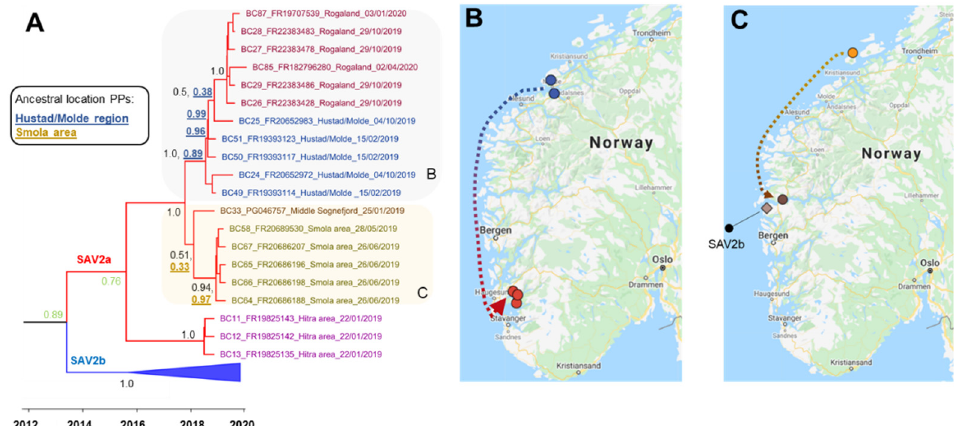
Figure 5. ( A ) Time-calibrated Bayesian phylogeny (Figure 4), focussing on the SAV2a clade, including results of the phylogeographic model. Tip names are colored according to the region of sample origin. PP values for key nodes are shown in black font. PP values for the ancestral location of samples are shown at relevant nodes, using font colors matching the given key for different aquaculture regions. ( B ) Inferred scenario of SAV2a spread from the Hustad/Molde area to Rogaland. ( C ) Inferred scenario of SAV2a spread from the Smøla area to Middle Sognefjord.